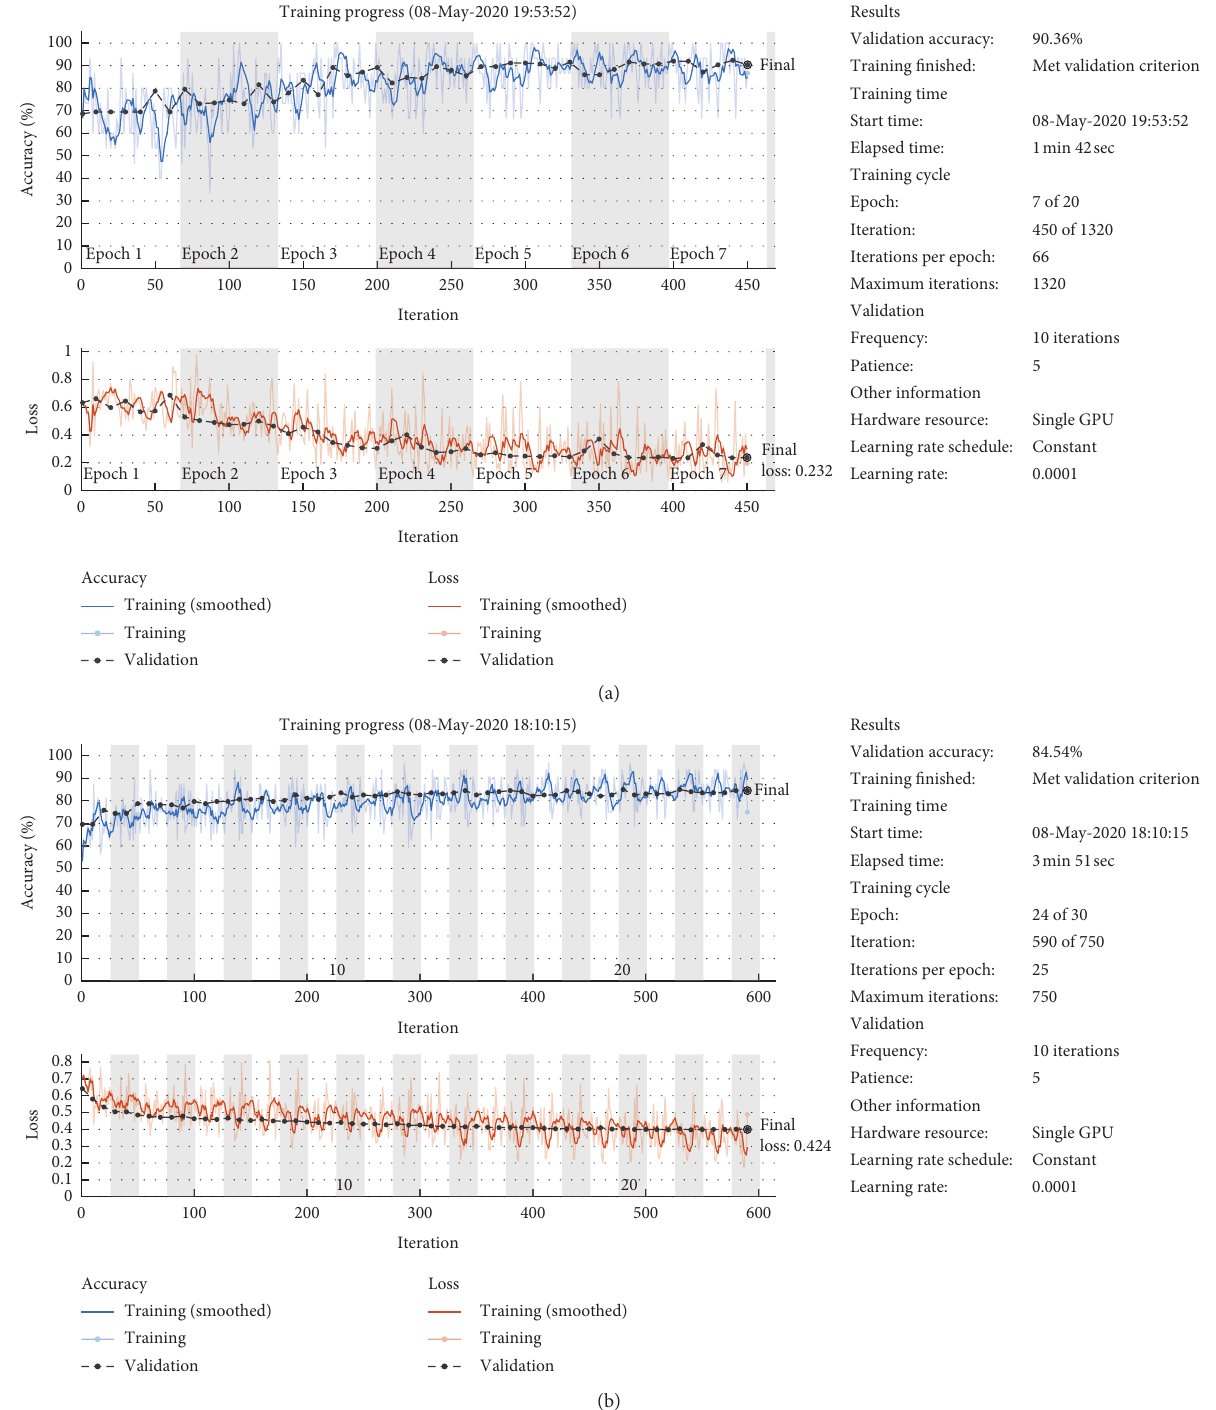
Figure 7: The loss and accuracy training process of cgau1 and segment-300 and MATLAB scalogram and segment-300 in CNN-GoogLeNet by transfer